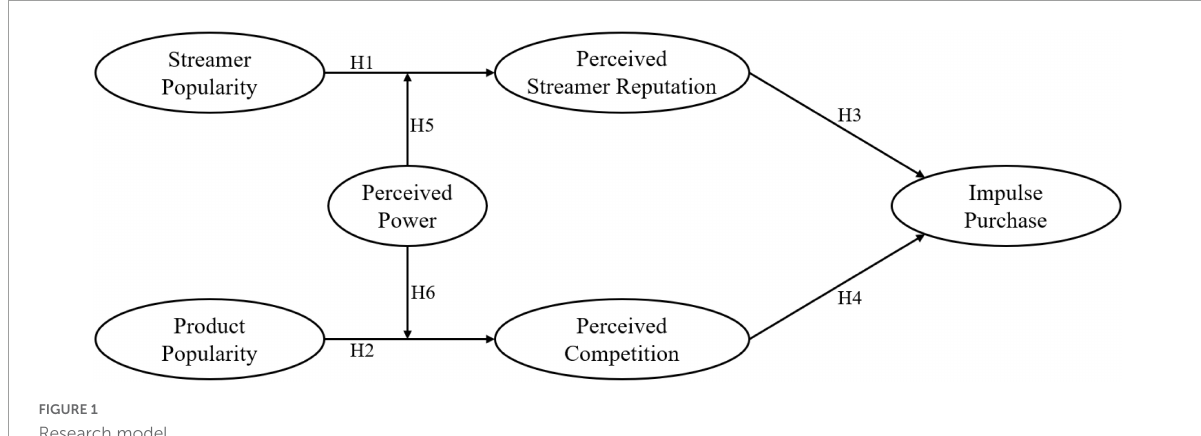
FIGURE1 Research